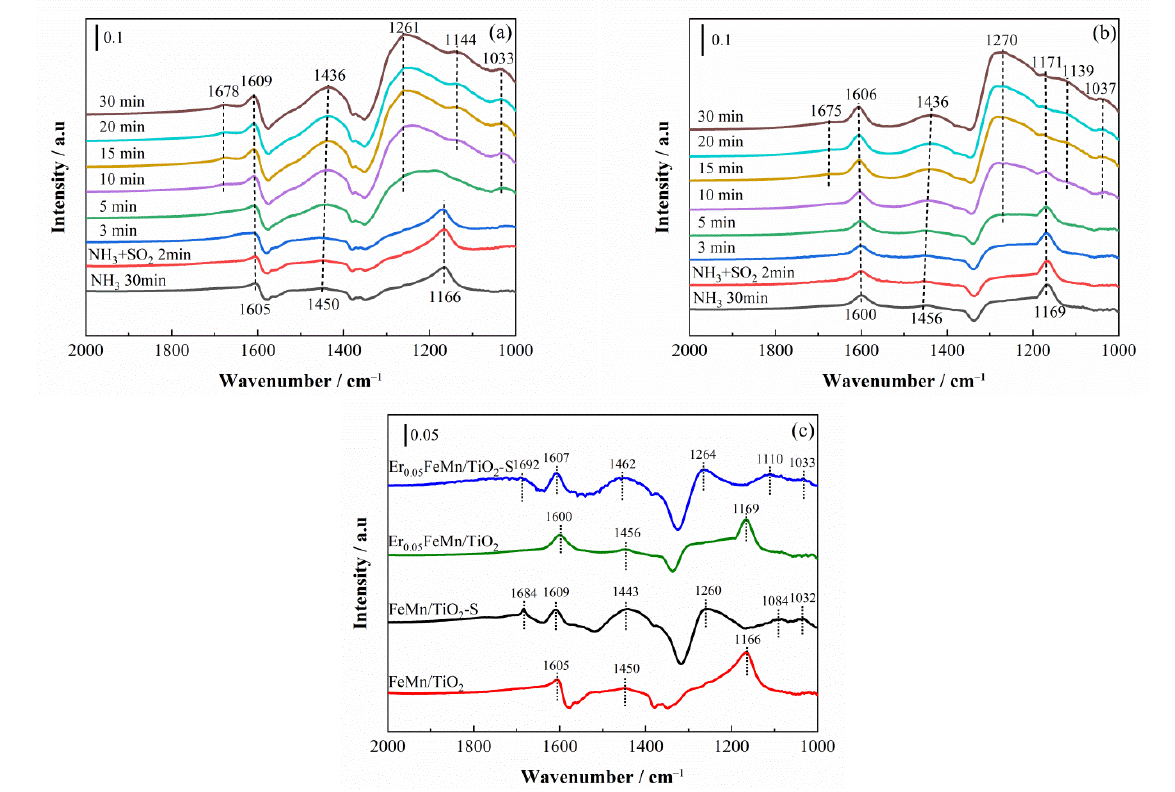
Figure 8. In-situ DRIFTS spectra FeMn/TiO 2 ( a ) and Er 0.05 FeMn/TiO 2 ( b ) catalysts exposed to 500 ppm NH 3 followed by the introduction of 100 ppm SO 2 at 200 °C, and in-situ DRIFTS spectra of adsorption 500 ppm NH 3 over the fresh and used catalysts at 200 °C ( c ).